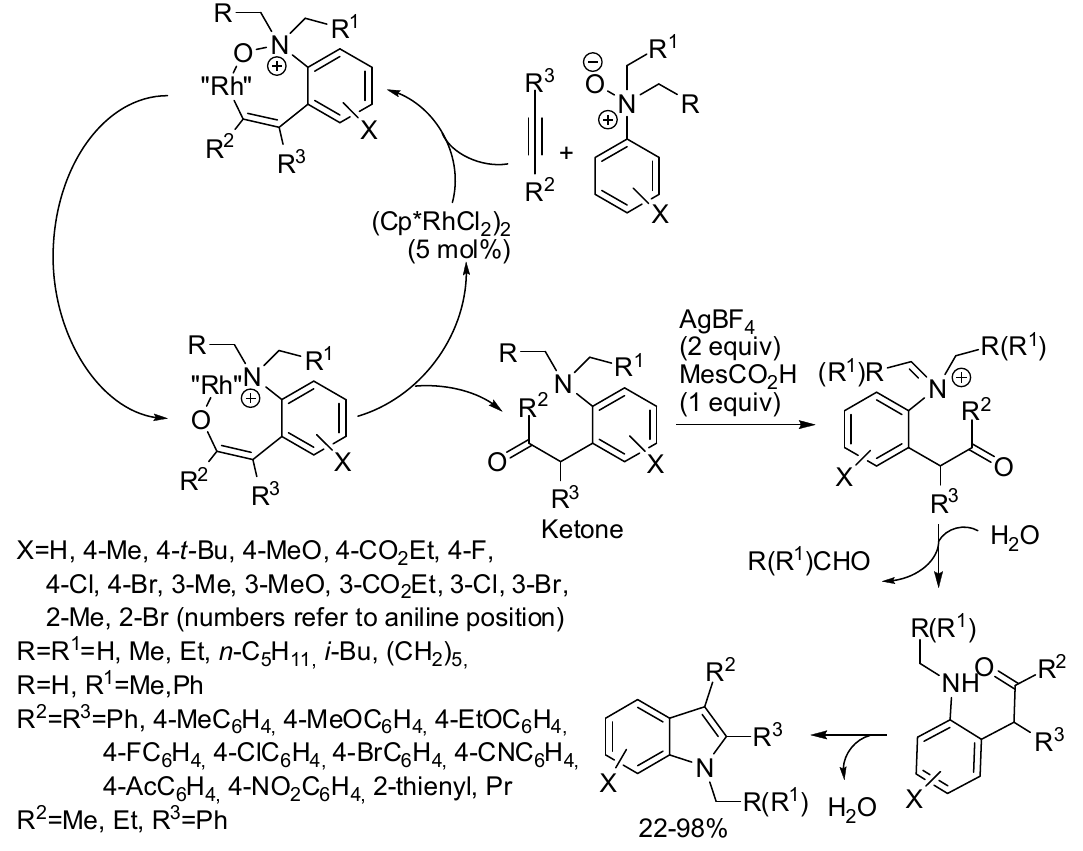
Scheme 49. Rhodium-catalyzed annulation of tertiary aniline N